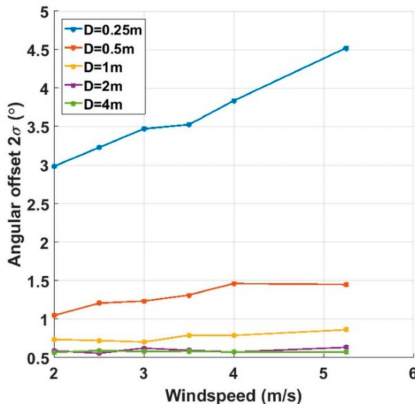
Figure 8. The effect of laser beam footprint diameter on the refraction angle standard deviation in the along-wind direction for an off-nadir angle of 15 ◦